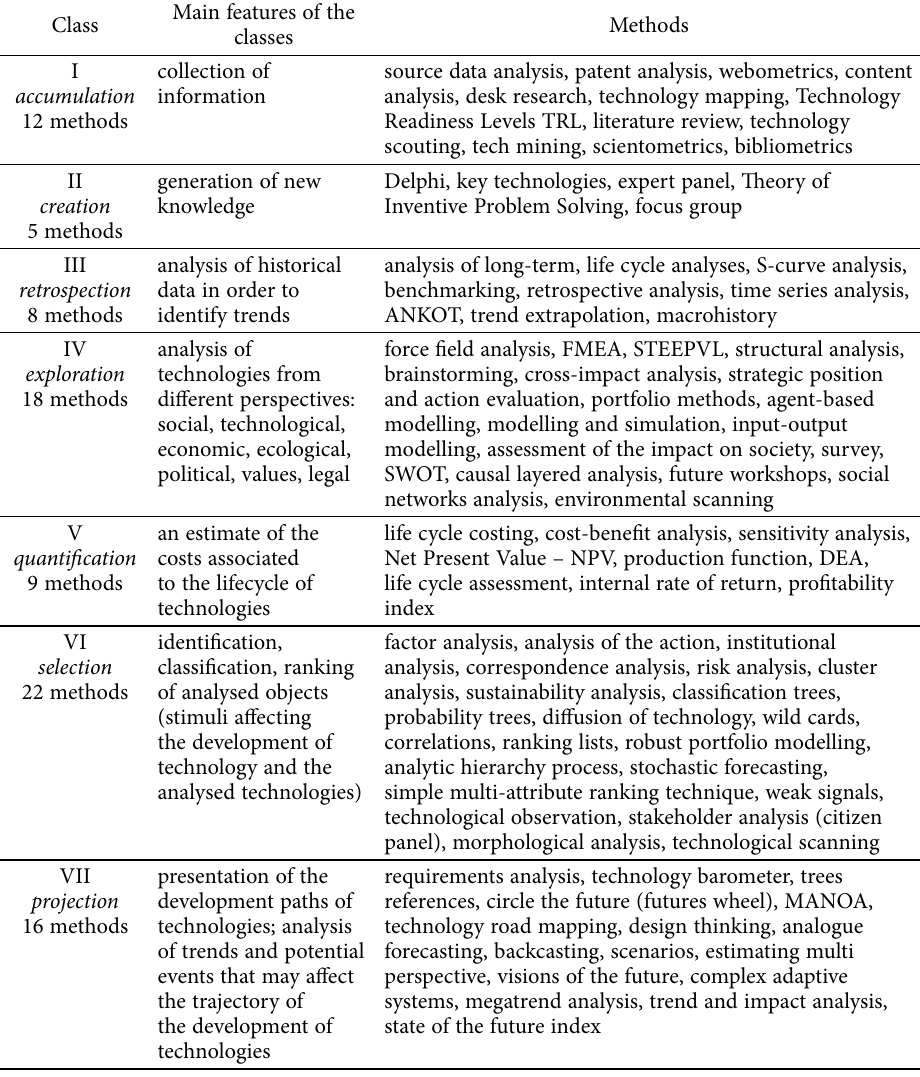
Table 3. Authorial classes together with the FTA research methods belonging to them